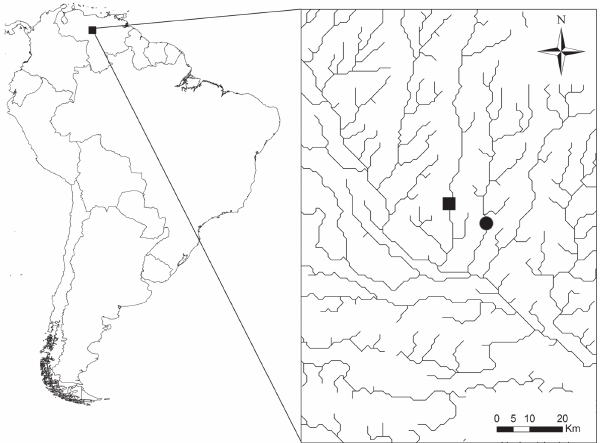
Fig. 1. Map showing locations of the two streams in the Llanos of the Orinoco Basin, Venezuela, Charcote (black dot) and Morichal Charcotico (black square), where fish trophic networks were studied. During September (late wet season), the Charcotico channel width averaged ca . 2.5 m, and one large pool that was surveyed measured 75 m x 47 m (max depth 1.22 m).